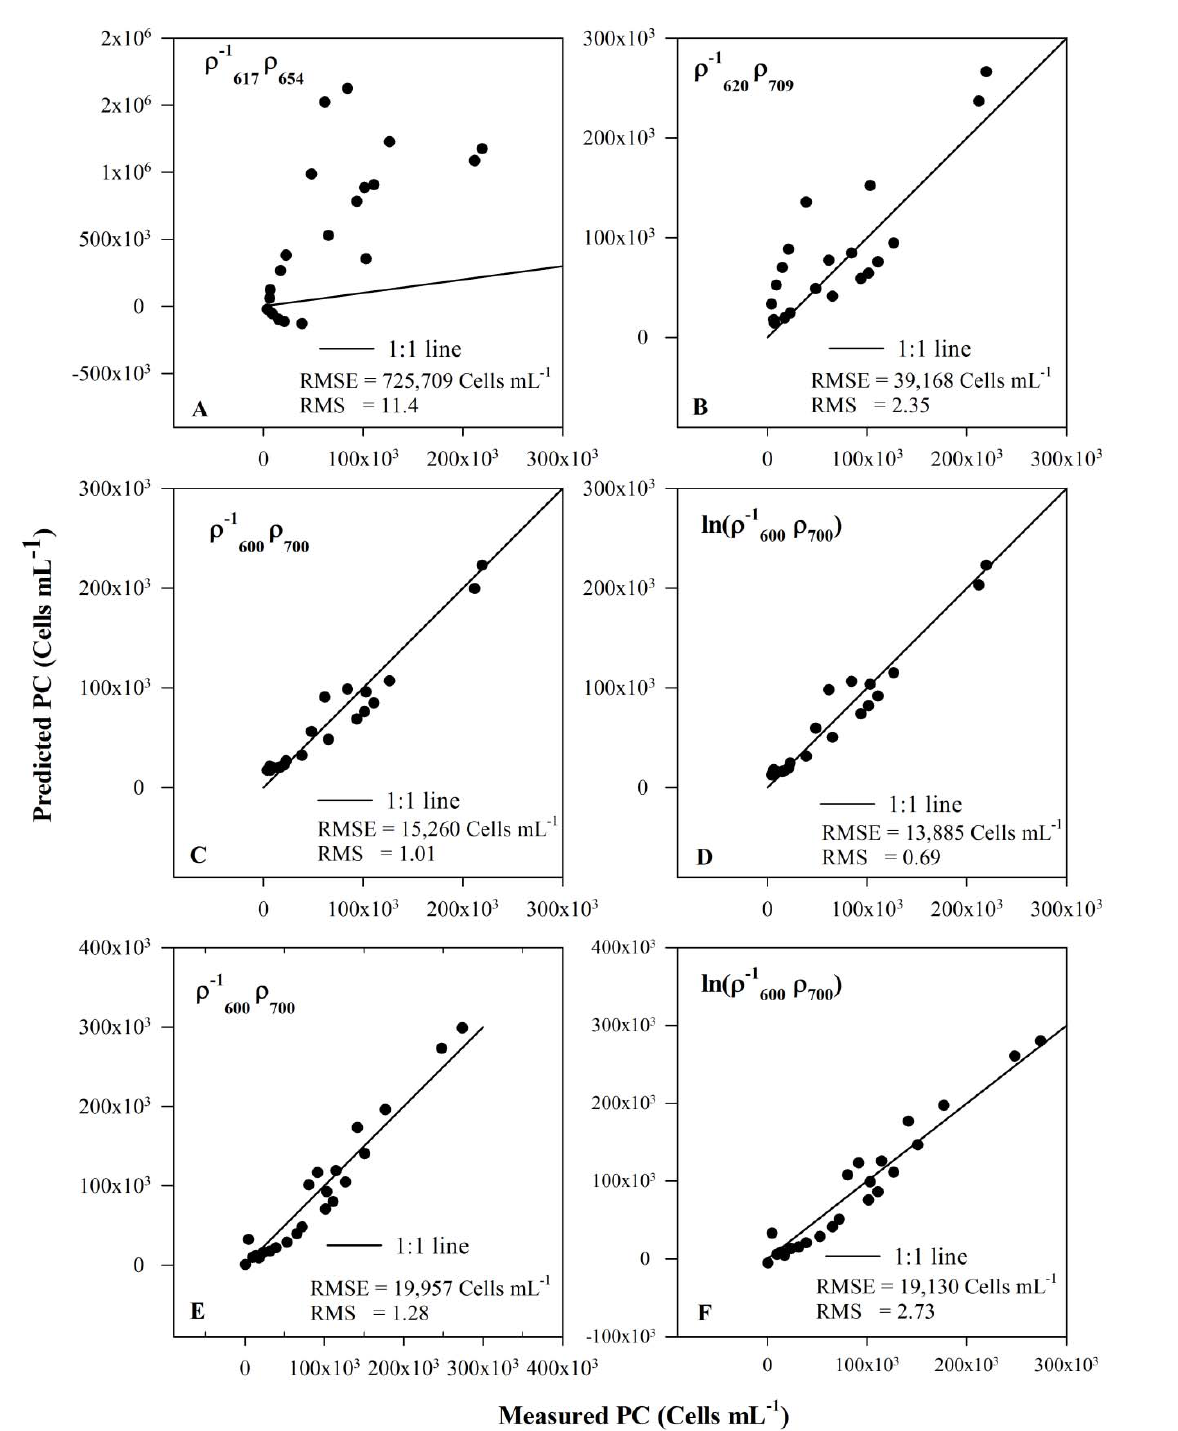
Figure 6 . Validation scatter plots of different models. The solid lines represent the 1-to-1 lines: (A,B,C,D) data from EXP I,II and III ( Synechocystis ) and (E,F) data from EXP I–IV ( Synechocystis and Anabaena ). Root-mean-square-error (RMSE) and relative root-mean-square-error (RMS) for each model are also reported. Note that model predicts many negative